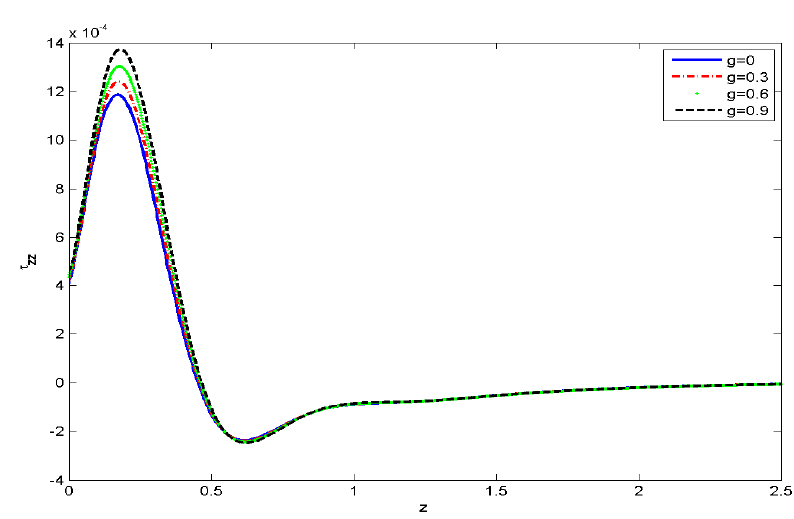
Figure 30. Shear stress xz